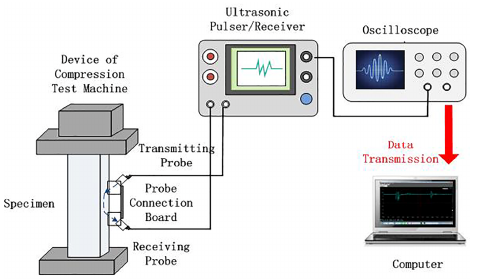
Figure 3. Subsurface stress measurement system for the gas-insulated metal-enclosed switchgear (GIS) epoxy specimen using the ultrasonic LCR wave.